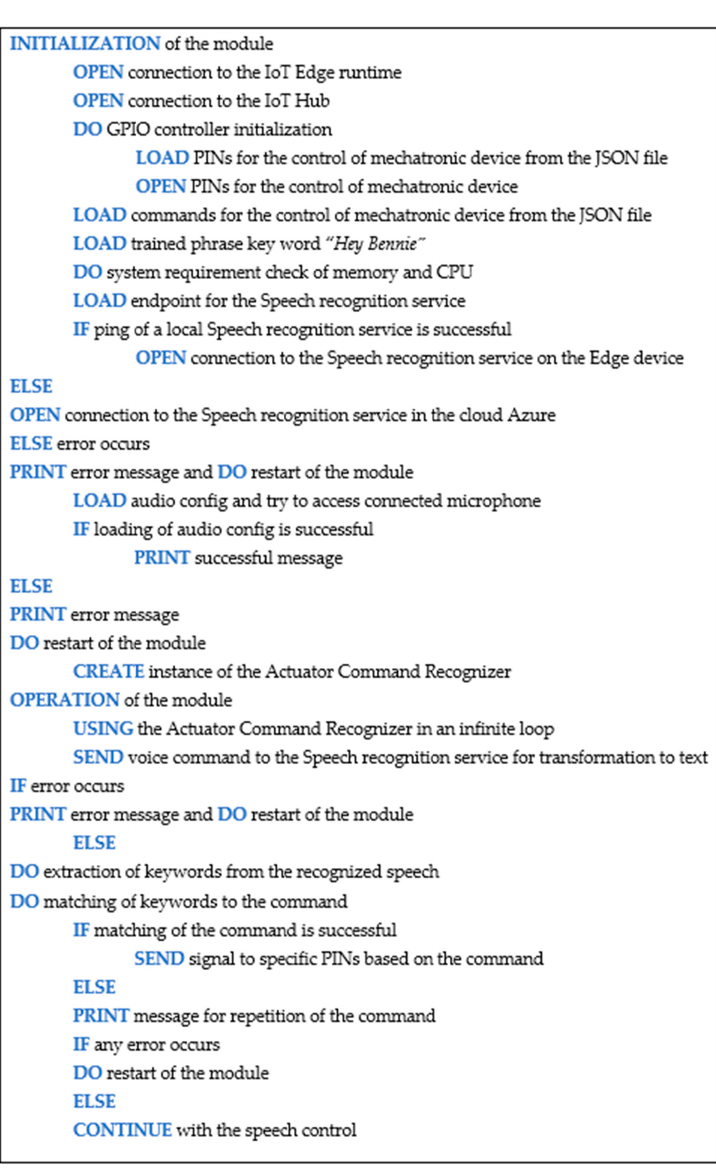
Figure 10. Pseudocode of voice recognition module.